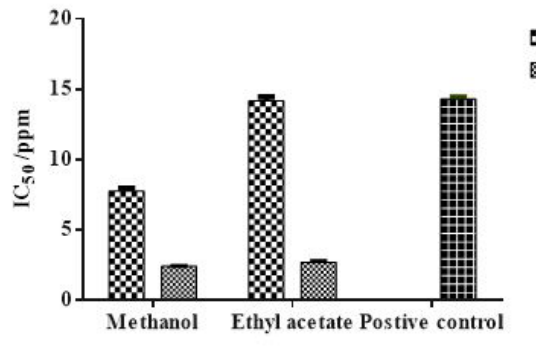
values of antioxidant activity of the extracts of D. falcata . Figure 1: Variation of the IC 50